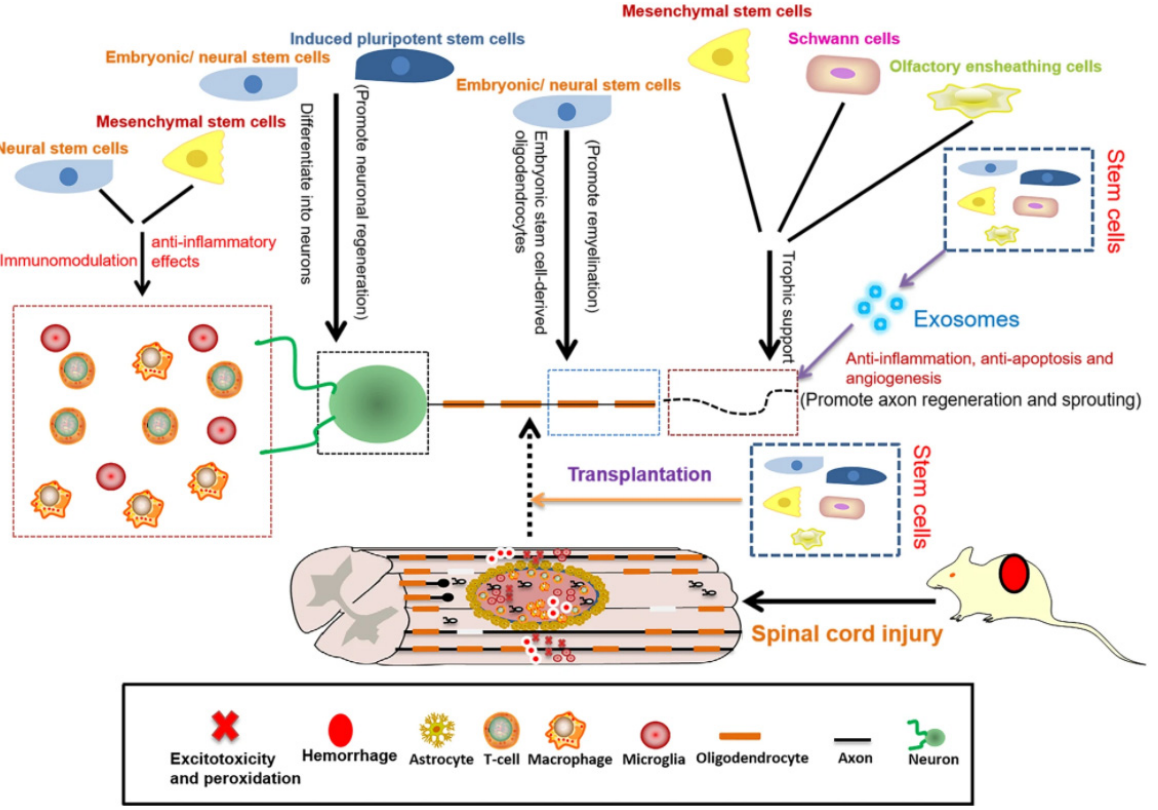
Figure 4. Schematic representation of the roles of stem cells in SCI repair. Reprinted from an open-access source [18].